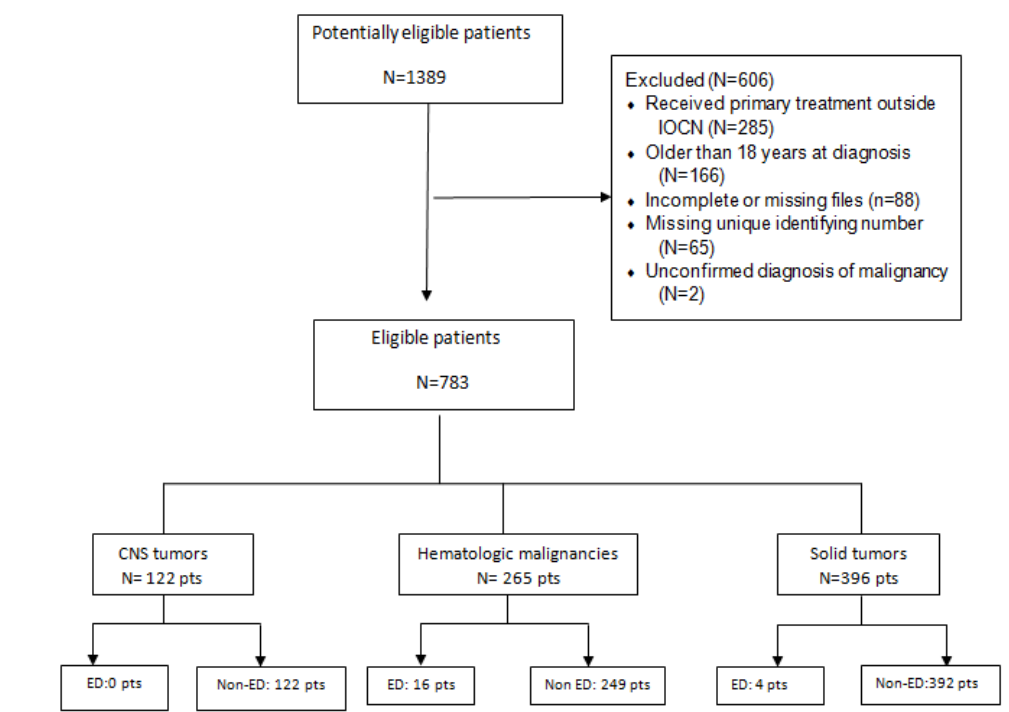
Figure 1. Diagram of patient flow. CNS—central nervous system; pts—patients; ED—early death. Causes of Early Death